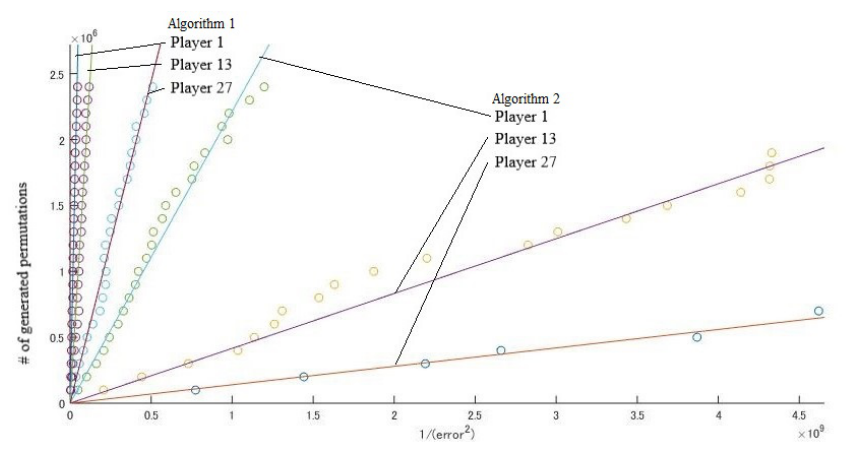
Figure 2. EU Council.